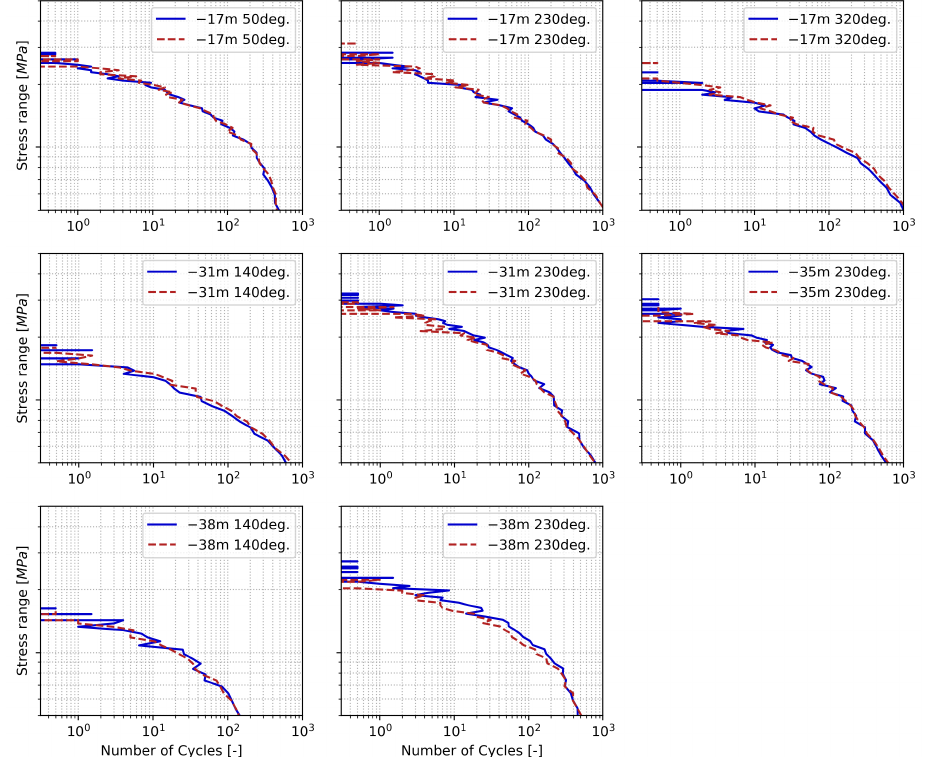
Figure A6. Zoom into fatigue spectra for sensors on the MP with measurement (solid) and estimation